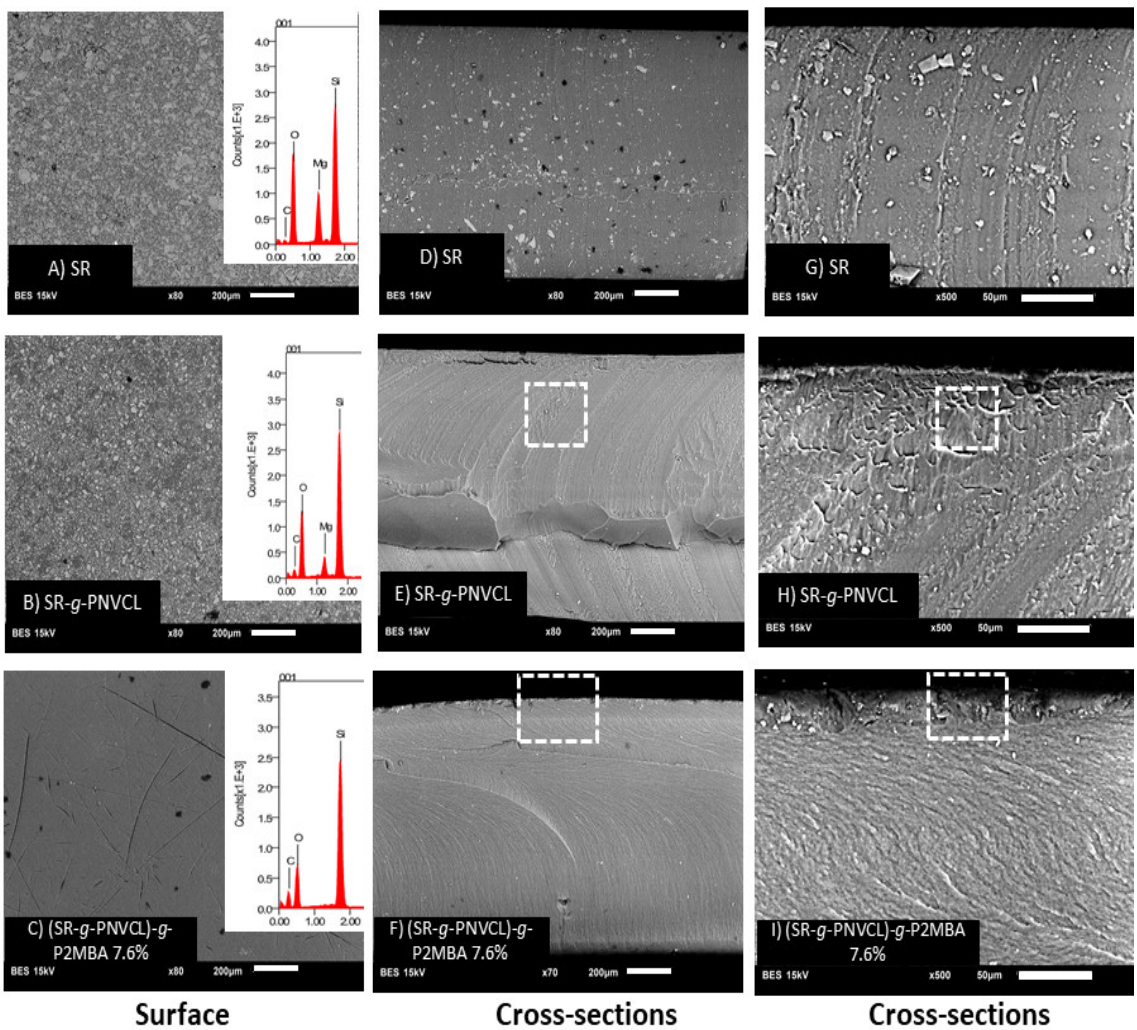
Figure 5. SEM images of the surface of ( A ) SR, ( B ) SR- g -PNVCL, ( C ) (SR- g -PNVCL)- g -P2MBA 7.6%, and the cross-section of SR, SR- g -PNVCL, and (SR- g -PNVCL)- g -P2MBA 7.6% ( D – F ) (200 µm); ( G – I ) (50 µm)). Dashed line square indicates grafting areas.